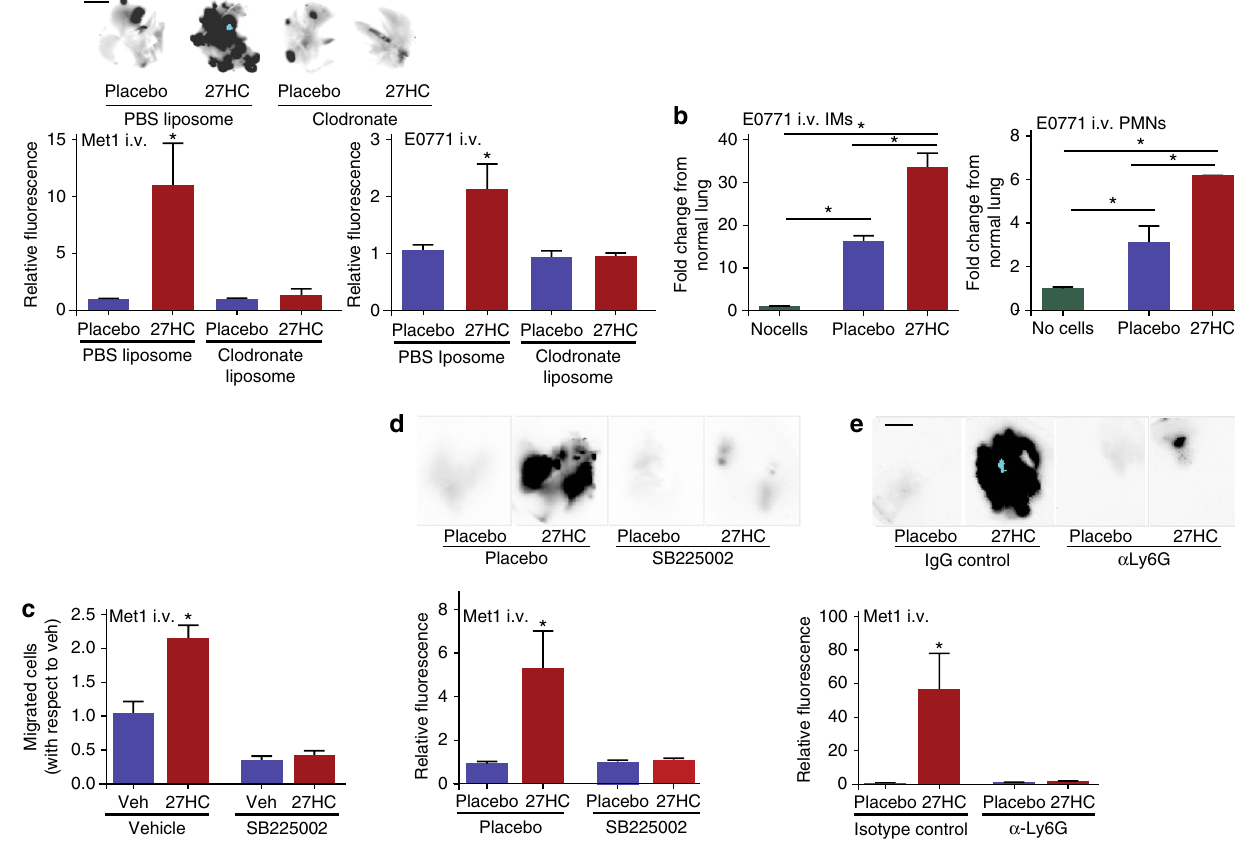
Fig. 3 Metastatic effects of 27HC require polymorphonuclear neutrophils. a Myeloid-derived immune cells are required for the colonizing effects of 27HC, as clodronate-liposome depletion of phagocytic cells ablates its effects. Mice were pretreated prior to cellular graft (i.v.) with placebo or 27HC and/or liposomes containing either PBS or clodronate as outlined in Fig. 2a. Representative images of iRFP-expressing Met1 colonies (depicted as black ) within the lungs are presented above quanti fi ed data for both Met1 and E0771 mammary cancer models (Met1 in order from left to right N = 5, 3, 3, 4, E0771 in order from left to right N = 3, 3, 4, 4, scale bars indicate 5 mm). b 27HC treatment of metastasis bearing mice results in the recruitment of in fl ammatory monocytes (IMs) and polymorphonuclear neutrophils (PMNs) to the lung, as assessed by FACS analysis (in order from left to right N = 3, 3, 6).